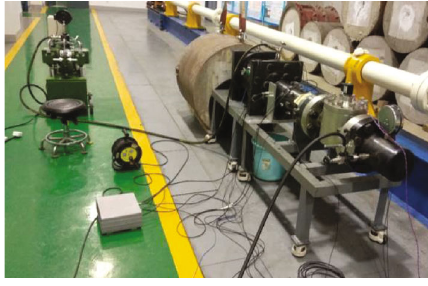
Figure 13: Completely built experimental system.